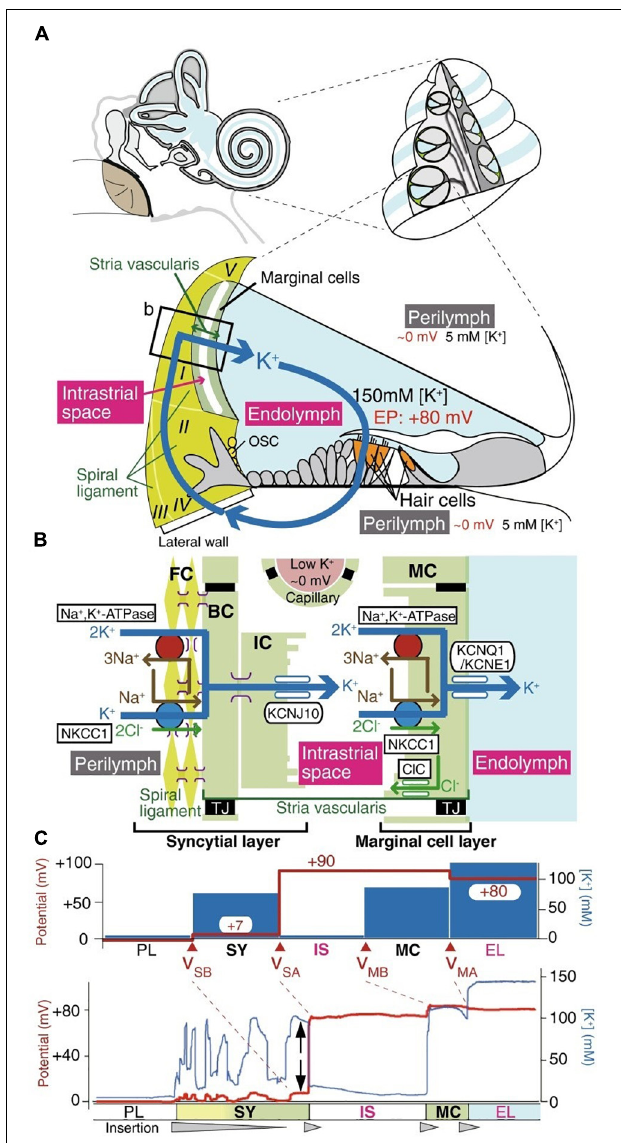
FIGURE 2 | The electrochemical profile of the cochlea. (A) The structure of the human ear and a cross-section of the cochlea are illustrated in the upper panel. The tissue and cellular composition of the cochlea are illustrated in the lower panel; this shows the electrochemical properties of the endolymph and perilymph and the possible circulation of K + ions between them. The boxed region in the lower panel is shown in (B) . (B) Structural and cellular composition of the lateral wall of the cochlea depicting key ion channels and transporters that are thought to maintain the unidirectional K + transport across the lateral wall and the endocochlear potential (EP) they produce are shown. (C) Membrane potential and [K + ] of the lateral wall under physiological conditions. The top panel displays the membrane potential and [K + ] averaged from multiple measurements. The membrane potential across the basolateral and apical surfaces of the syncytial layer, vSB and vSA, respectively, and the basolateral and apical surfaces of the marginal cell layer, vMB and vMA, respectively, are shown. The lower panel shows a representative trace of the measurement of the membrane potential and the [K + ] in the cochlea of a live guinea pig. [Reproduced and modified with permission from the copyright holders the National Academy of Sciences (Nin et al., 2008) and Springer-Verlag Berlin Heidelberg (Yoshida et al.,